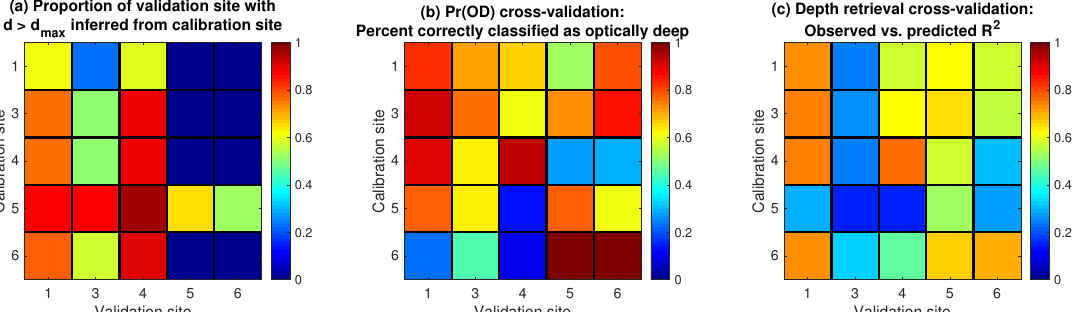
Figure 12. Inter-site cross-validation of spectrally based bathymetric mapping by applying results from a calibration site (matrix rows) to a distinct validation site (matrix columns). ( a ) Proportion of the validation site data deeper than the d max inferred via OPTID at the calibration site; ( b ) percent of the validation site correctly classified as optically deep when applying the Pr(OD) relation from the calibration site; ( c ) observed versus predicted R 2 for depth estimates at the validation site based on the OBRA relation established at the calibration